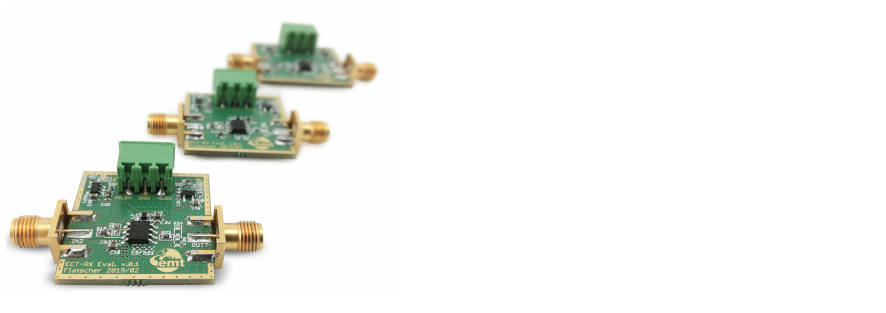
Figure 9. Realized circuits of the theoretical representations in Figure 4 to perform compara- tive measurements.